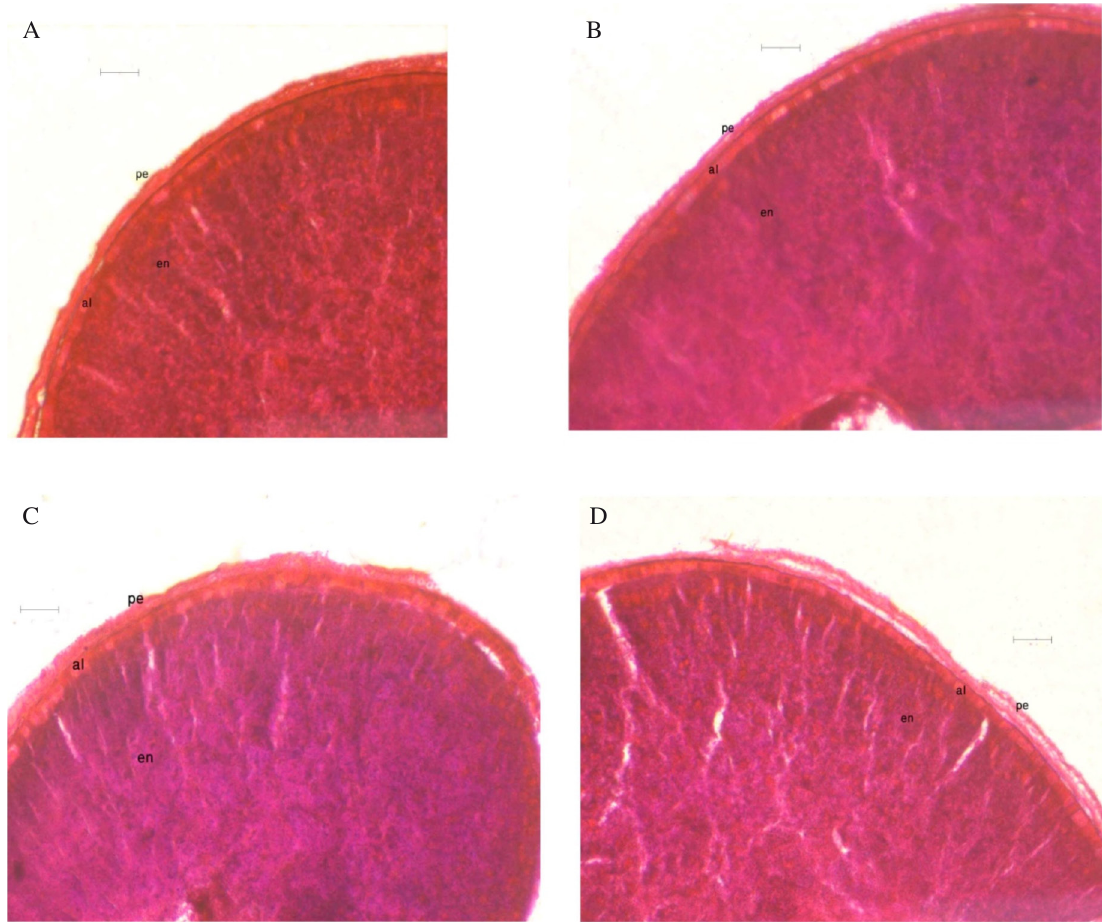
Fig. 1: Photographs of grain section of Azospirillum lipoferum N040 inoculated Triticum aestivum L. plants grown under water stress. A) Non-inoculated + 100% ETc; B) Inoculated + 100% ETc; C) Non-inoculated + 60% ETc; D) Inoculated + 60% ETc; al, aleurone layer; en, endosperm and pe, percarp, bars = 200 μm.